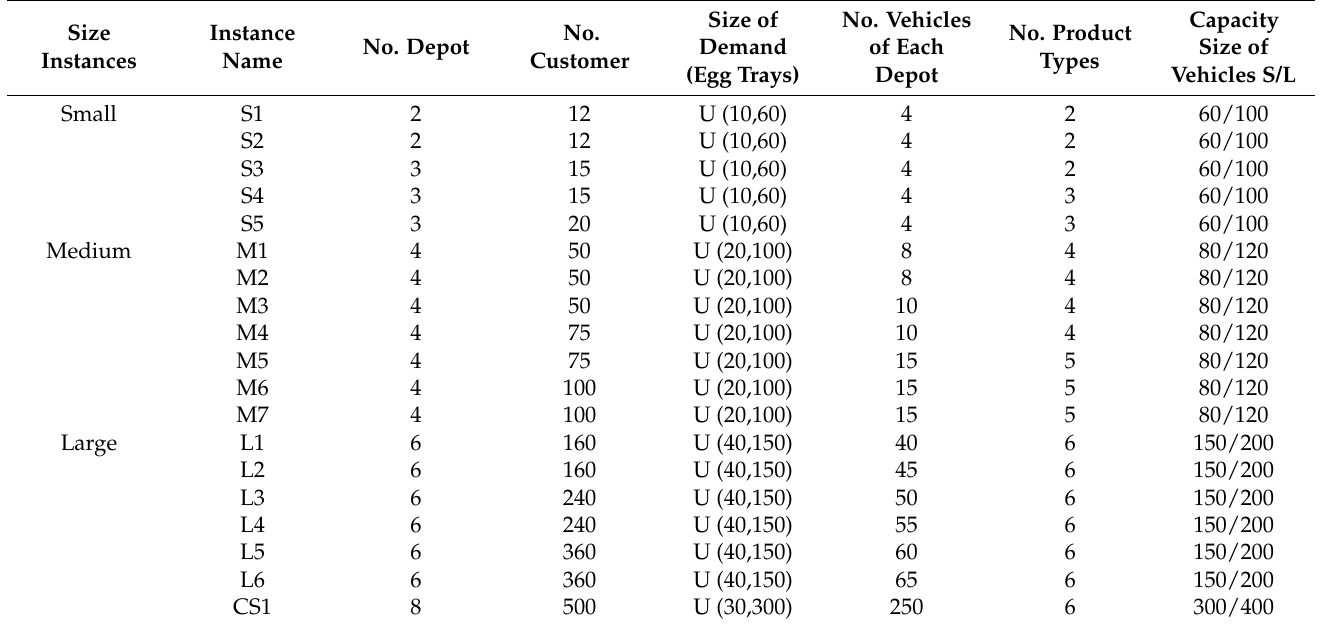
Table 3. The factors of data generated for each problem